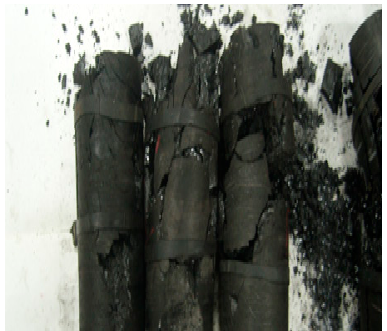
Figure 5. Failure pattern of coal samples.